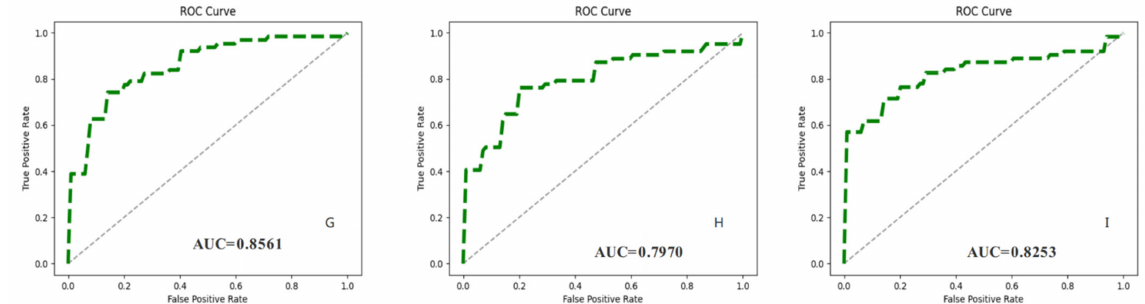
Figure 6. Receiver operating characteristic curves (ROCs) of all CNN models and their corresponding AUC values. ( A – C ) Represent the prediction results of MVI-Mind during AP, PVP, DP, respectively; ( D – F ) represent the prediction results of ResNet-34 during AP, PVP, DP, respectively; ( G – I ) represent the prediction results of Inception V3 during AP, PVP, and DP, respectively.